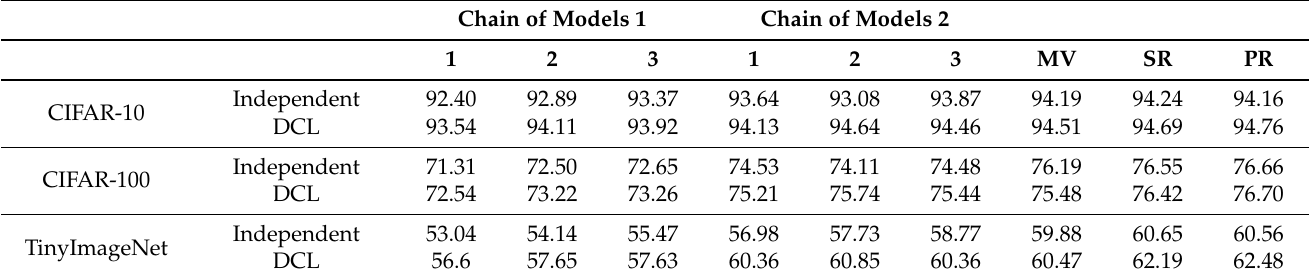
Table 4. A comparison of an ensemble of DCL models and independent models on CIFAR-10, CIFAR-100, and TinyImageNet. Chain of Models 1 Chain of Models 2